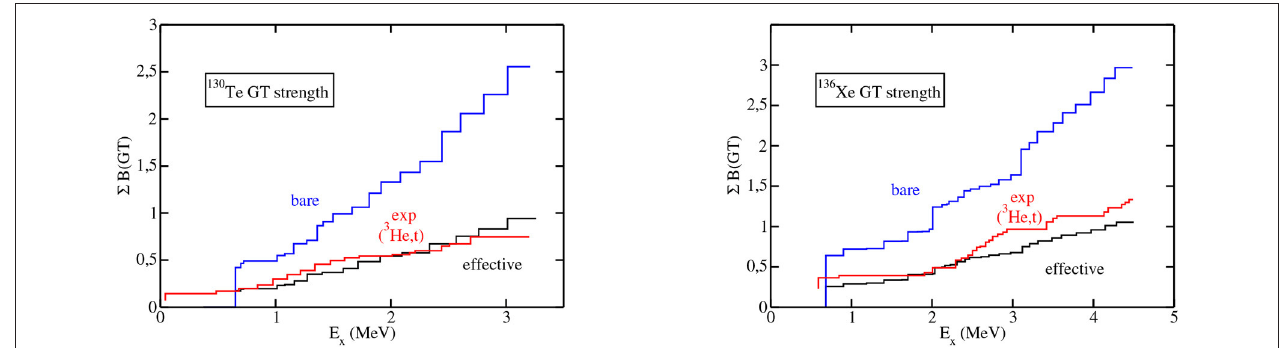
FIGURE 14 | Running sums of the B (GT) strengths as a function of the excitation energy E x up to 3 and 4.5 MeV, respectively, for 130 Te and 136 Xe. Reproduced from reference [102].